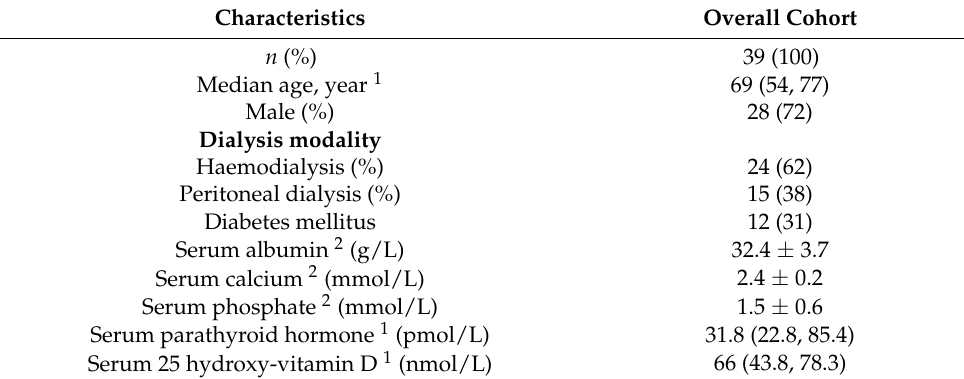
Table 1. Baseline characteristics of all patients on maintenance dialysis.